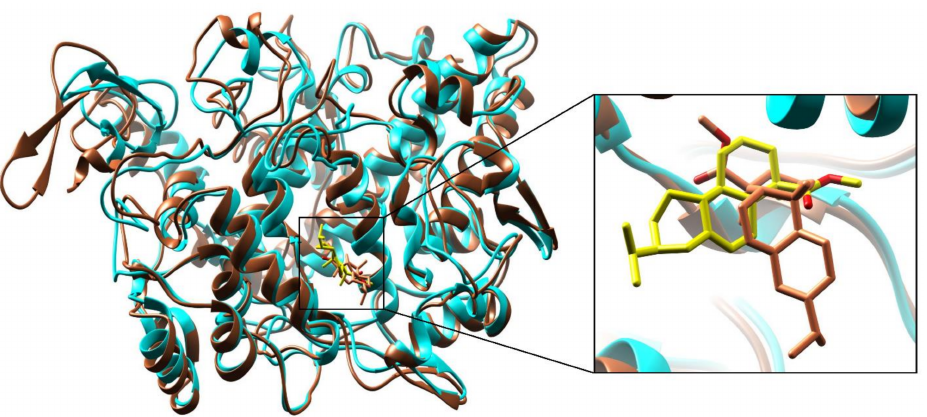
Figure 6. Superimposition of the compound ( 47 ) bounded with Cyclooxygenase-2 (COX-2) at 0 ns and 100 ns. The calculated RMSD value is 1.157 Å; protein at 0 ns is presented in Cyan and ligand in yellow color, while protein at 100 ns is presented in Sienna and ligand in coral color. Critical structural changes are shown in zoomed